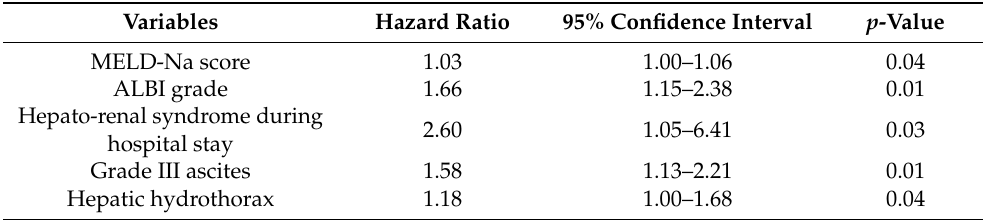
Table 3. Multivariate Cox proportional hazards model in the entire matched cohort ( n = 194 patients).